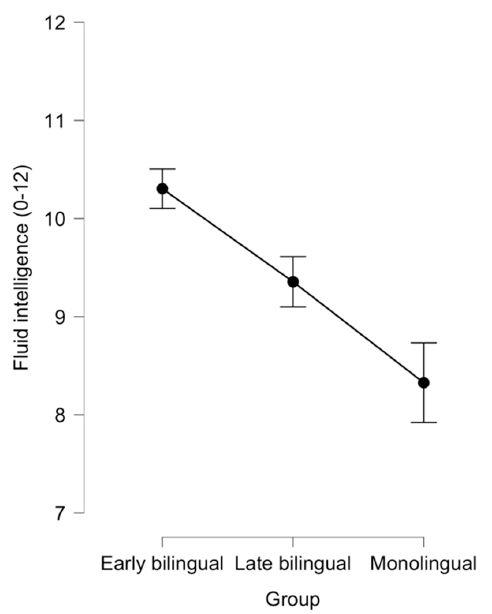
Figure 2. Early bilinguals demonstrated greater fluid intelligence than late bilinguals and monolin- guals. Error bars represent ±1 standard error of the mean.